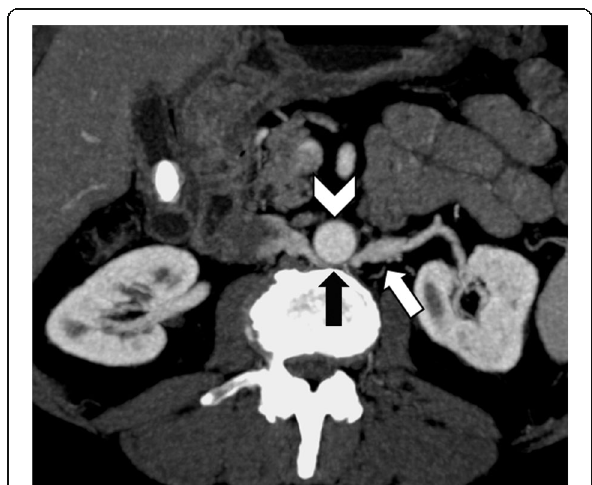
Fig. 6 A 78-year-old man with posterior nutcracker syndrome. Axial CT image on the arterial phase shows left renal vein (white arrow) compressed between the aorta (arrowhead) and the vertebral body (black arrow)